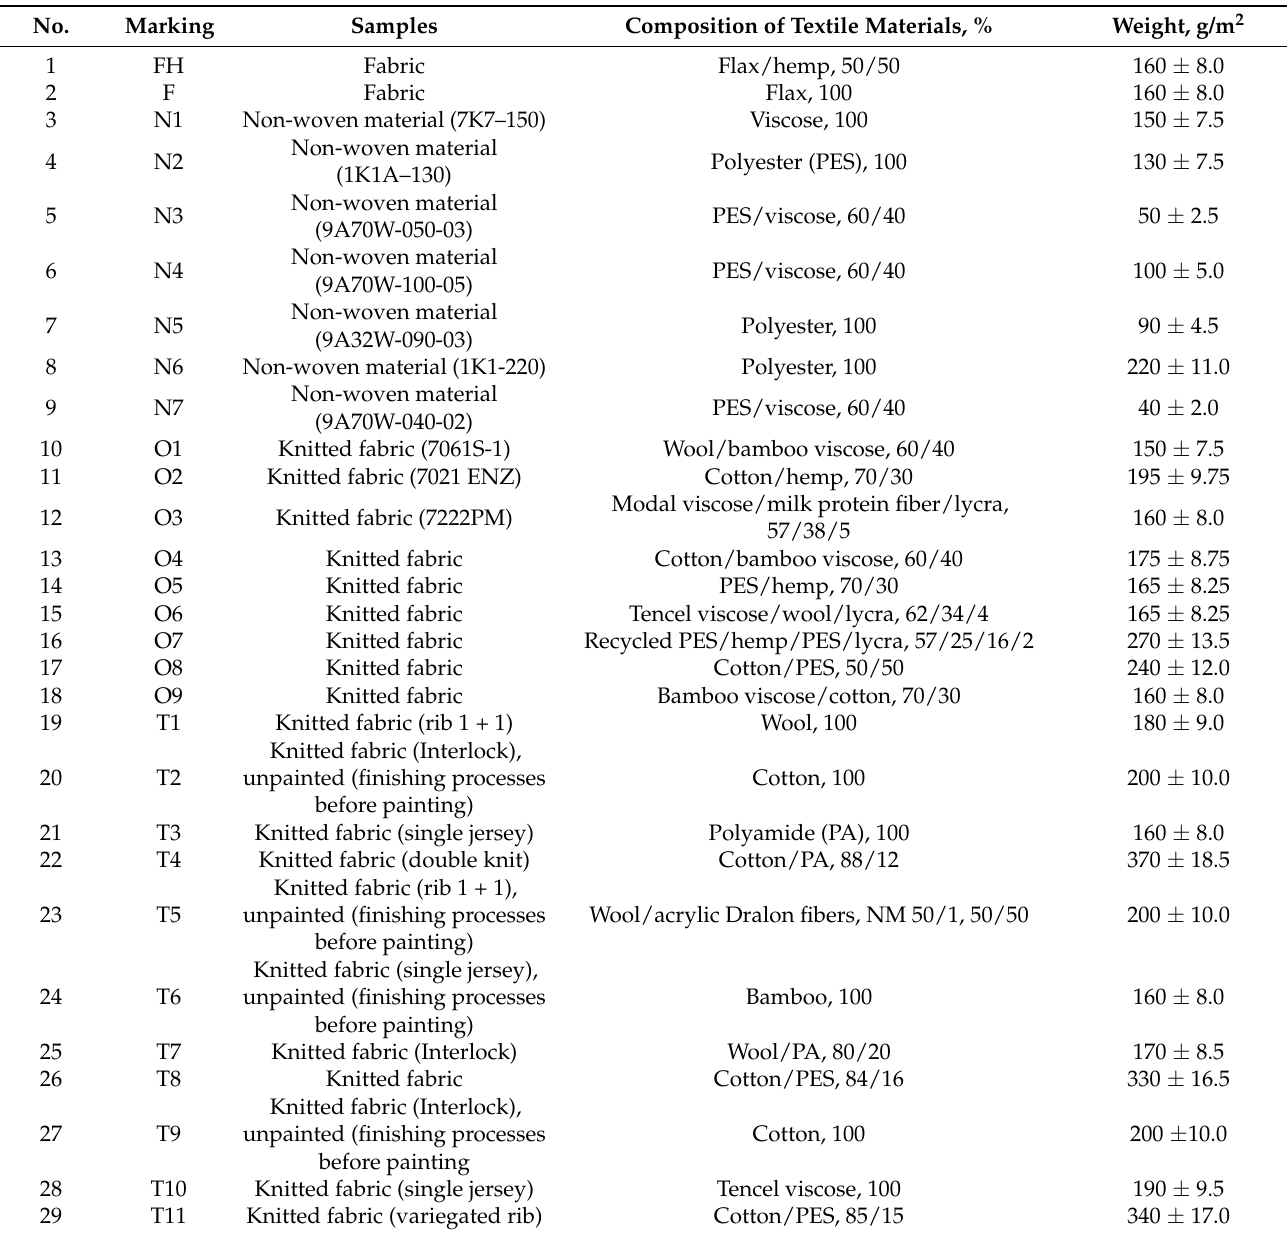
Table 1. Textile materials used in the